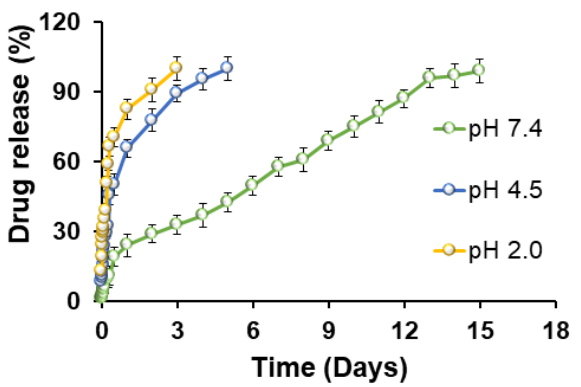
Figure 5. Drug release profile of AMX@Ctr–mpHANCs at pH 2.0, 4.5, and Figure 5 . Drug release profile of AMX@Ctr–mpHANCs at pH 2.0, 4.5, and 7.4.